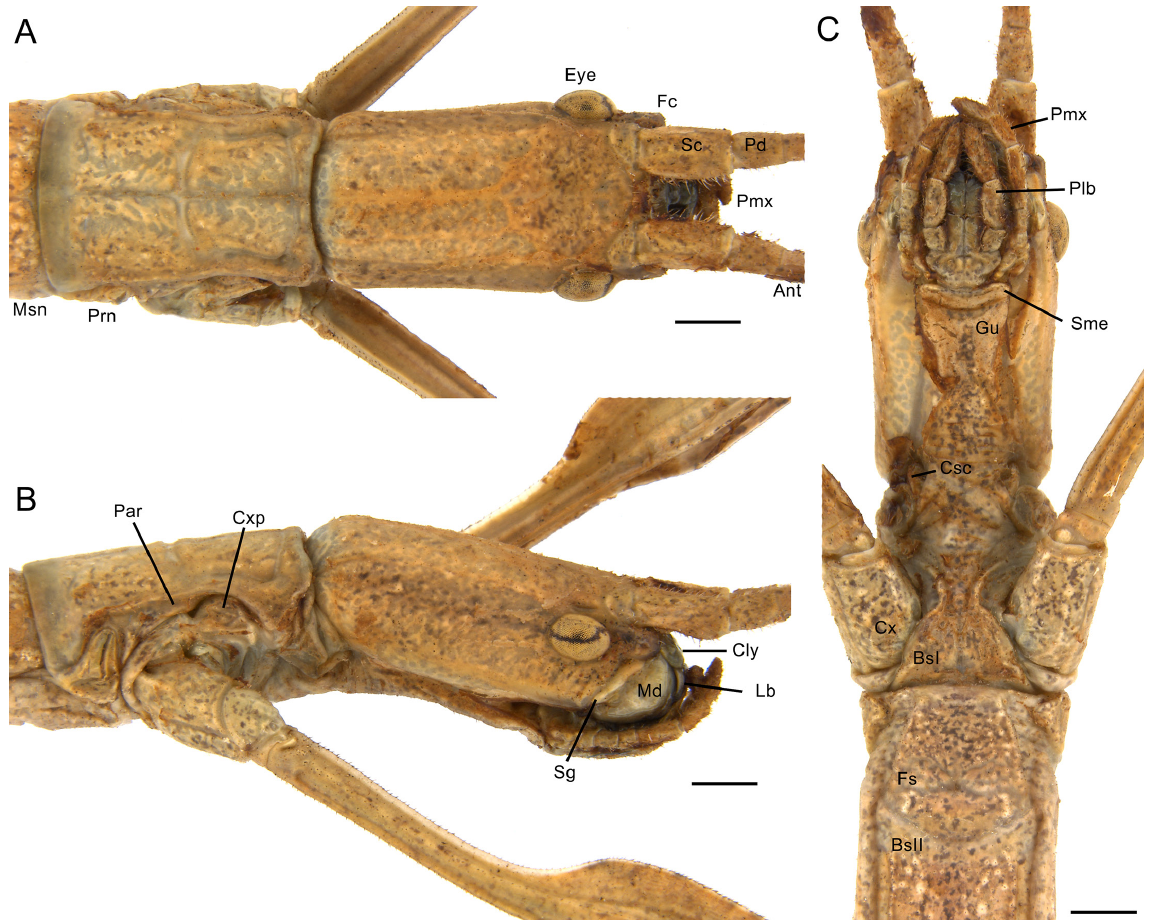
Fig. 35. Arumatia motenata Ghirotto gen. et sp. nov., holotype, ♀ (MZUSP V0603), head and prothorax morphology. A . Head and prothorax in dorsal view. B . Head and prothorax in lateral view. C . Head and prothorax in ventral view. Abbreviations: Ant = antennomere; BsI-II = pro- and mesothoracic basisterna; Cly = clypeus; Csc = cervical sclerite; Cx = coxa; Cxp = coxopleurite; Eye = compound eye; Fc = frontal convexity; Fs = prothoracic furcasternite; Gu = gula; Lb = labrum; Md = mandible; Msn = mesonotum; Par = paranota; Pd = pedicellus; Plb = labial palpus; Pmx = maxillary palpus; Prn = pronotum; Sc = scapus; Sg = subgena; Sme = submentum. Scale bars: 1